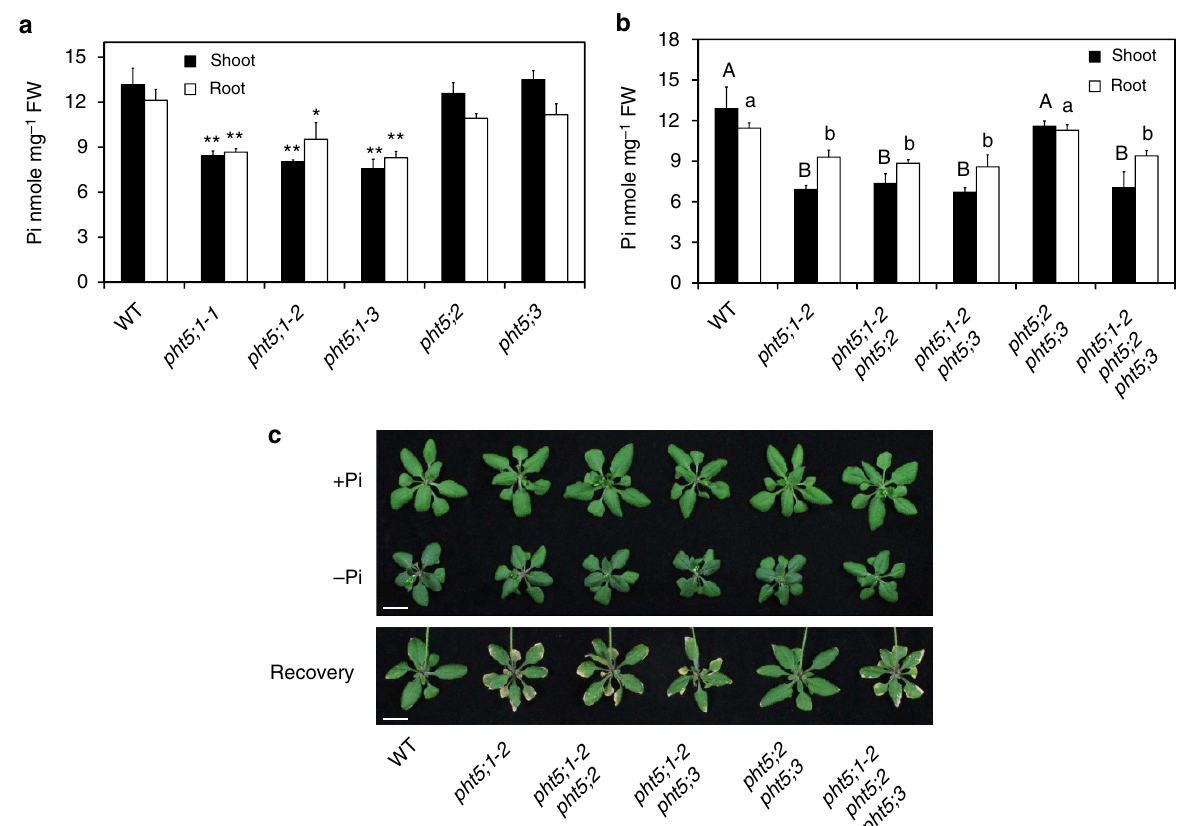
Figure 2 | The capacity of Pi storage and recovery is impaired in the pht5;1 mutants. The Pi level of WT, pht5;1-1 , pht5;1-2 , pht5;1-3, pht5;2 and pht5;3 plants ( a , asterisks indicate a significant difference compared with WT, * P o 0.05, ** P o 0.01, Student’s t -test) and their respective double and triple mutants ( b , different upper and lower case letters represent a significant difference among genotypes in the shoot and root samples, respectively, analysis of variance P o 0.05) grown under Pi-sufficient conditions. The phenotype of 21-day WT, pht5;1-2 , pht5;1-2 pht5;2 , pht5;1-2 pht5;3 , pht5;2 pht5;3 and pht5;1-2 pht5;2 pht5;3 plants grown under Pi-sufficient ( þ P) and Pi-deficient ( (cid:2) Pi) conditions, and after 3 days of Pi replenishment following 3 days of Pi starvation (Recovery) ( c ). Error bar, s.d. ( n ¼ 3). Scale bars, 10mm. Results were reproducible in at least three independent